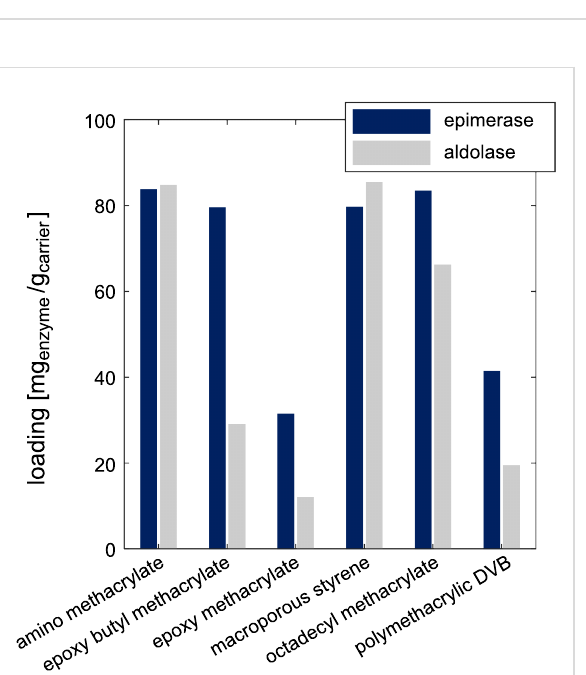
Figure 3: Evaluation of immobilized epimerase on different carriers with respect to specific activity. Reaction conditions: 40 °C, pH